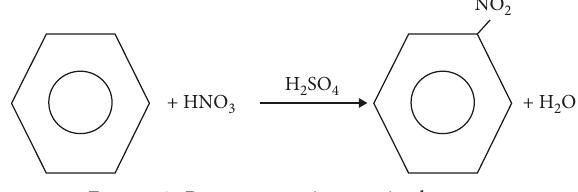
Figure 2: Benzene reaction to